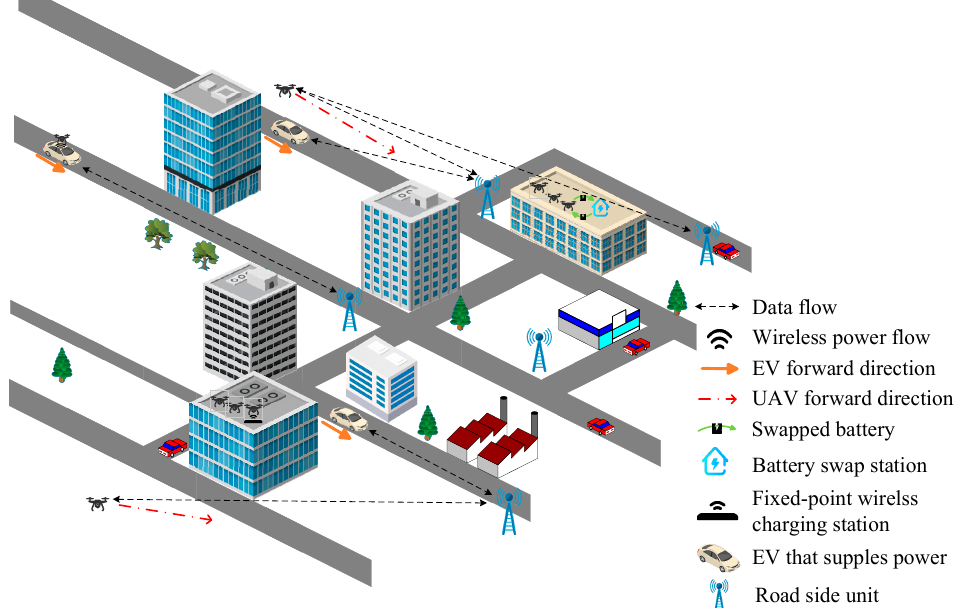
Figure 1. UAV charging in a sample scenario.